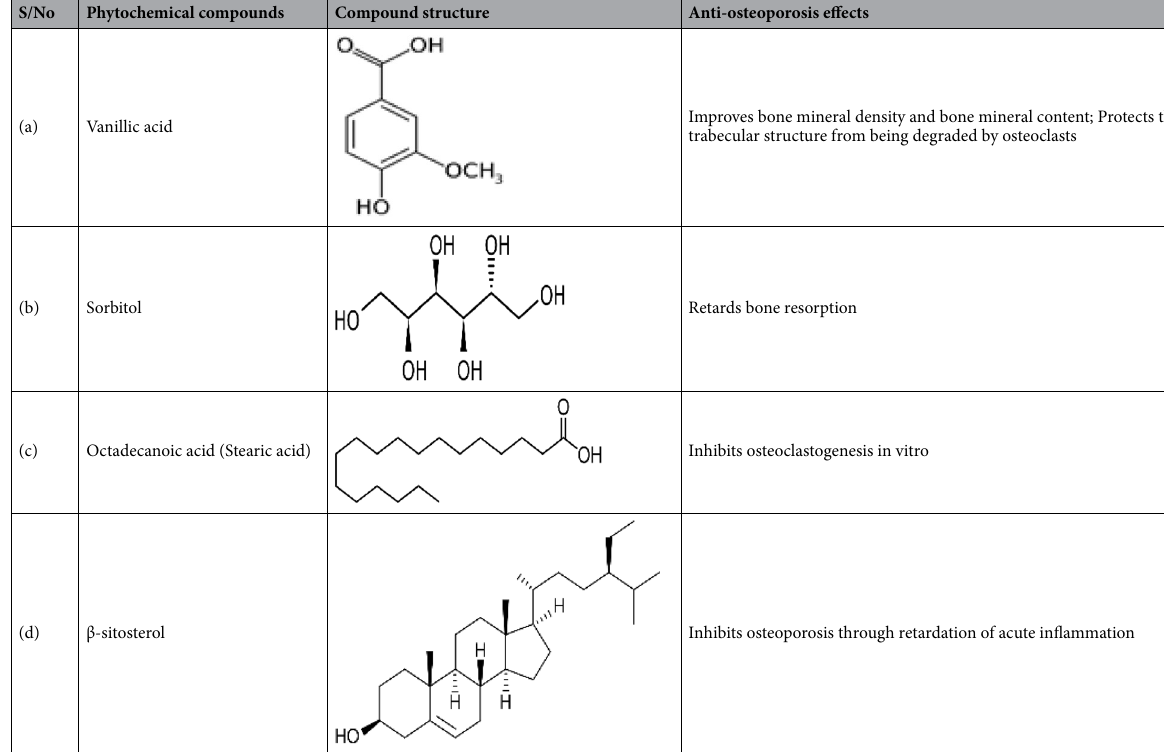
Table 3. Summary of the previous studies on anti-osteoporosis effects of some of the compounds identified in P. africana.